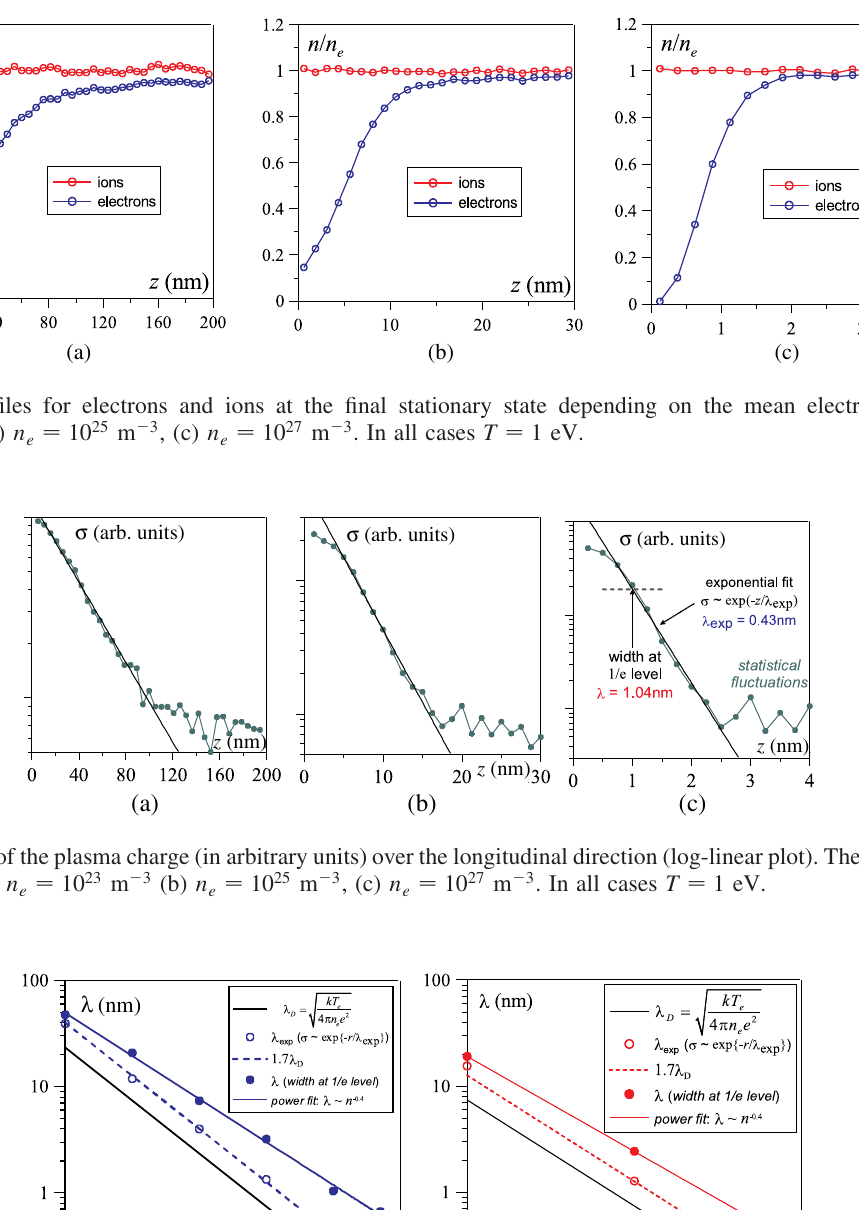
(cid:1) and (cid:1) D are primarily a function of the plasma nonideality, defined as the ratio of average electrostatic